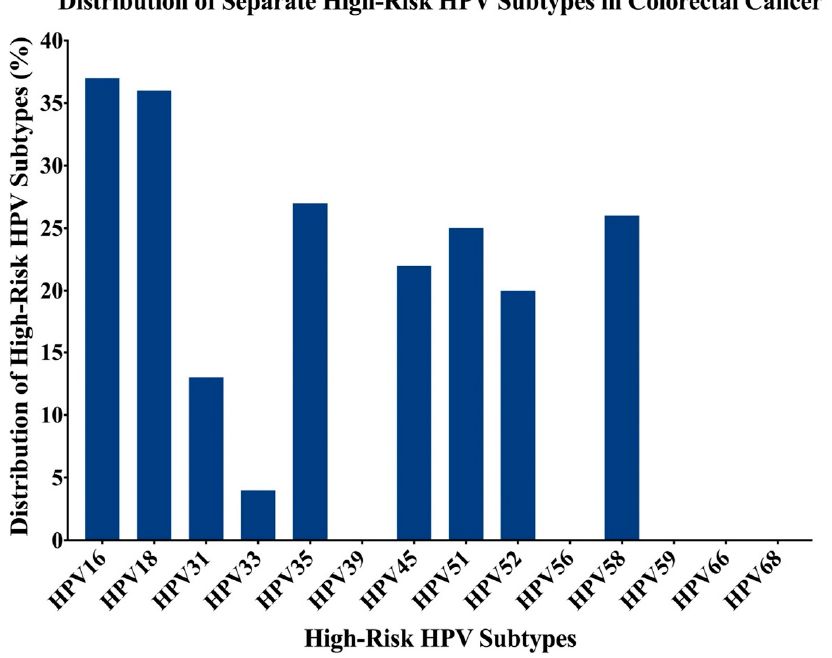
Figure 1. The distribution of each high-risk HPV subtype in Lebanese colorectal cancer samples. The PCR analysis included 94 colorectal cancer (CRC) samples revealing that the most frequent human papillomaviruse (HPV) subtypes are 16, 18, 35, 58, 51, 45, 52, 31, and 33. Table 2. Correlation of EBV and HPV-subtypes in Lebanese colorectal cancer patients. No. of Samples Cases